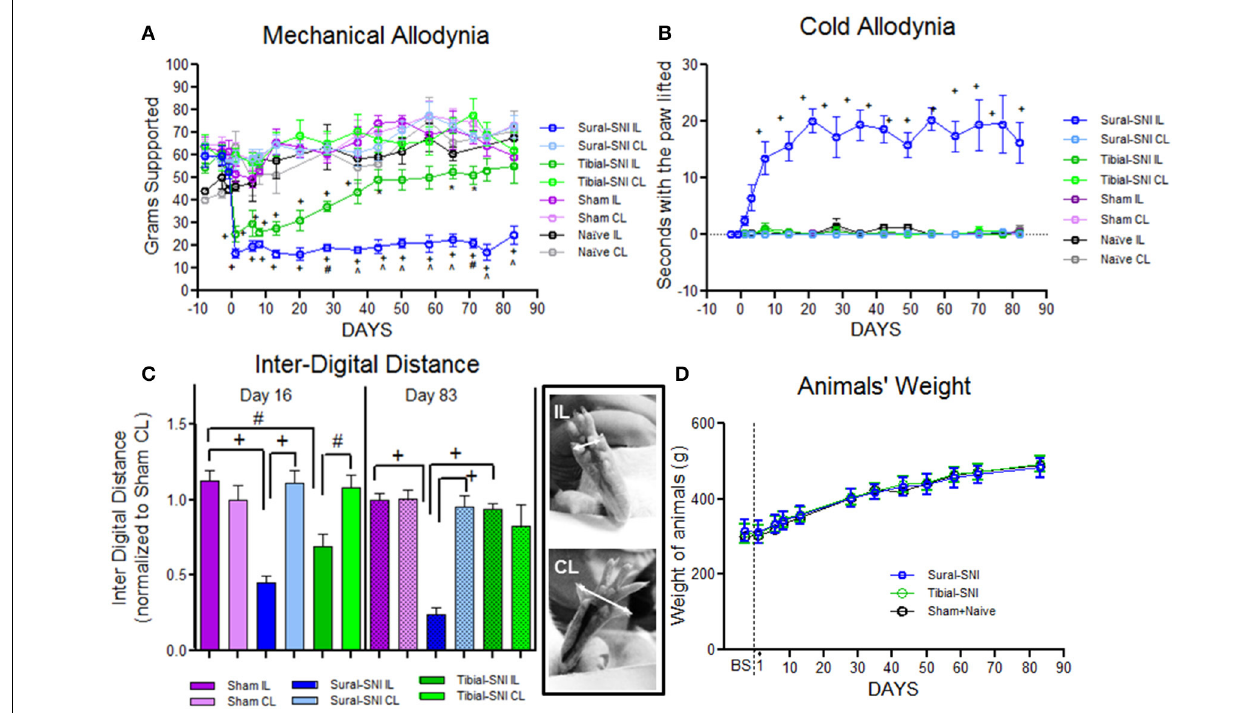
FIGURE 1 | Tibial-SNI and Sural-SNI display differences in their pain phenotype. (A) Mechanical allodynia measurements in the ipsilateral (IL) and contralateral (CL) paws of Sural-SNI, Tibial-SNI, Sham and Naïve rats. Only the Sural-SNI and Tibial-SNI groups showed responses that were significant different between their IL and CL paws: + P < 0 . 001, ∗ P < 0 . 05. In addition, a significant difference was found in the IL responses between Sural-SNI and Tibial-SNI starting at Day 28 post-surgery: ∧ P < 0 . 001, # P < 0 . 01. For Sural-SNI and Tibial-SNI, the number of rats was n = 10 for Days -8, -2, and -1 pre-surgery, and for Days 1, 6, 8, 13, and 28 post-surgery; n = 7 for Days 20, 37, 43, 50, and 58 post-surgery; n = 6 for Day 65 post-surgery, n = 4 for days 71, 75 post-surgery, and n = 5 for day 83 post-surgery. For Sham, n = 8 from Day -8 pre-surgery to Day 28 post-surgery, and n = 5 for the rest of the post-surgery days. For